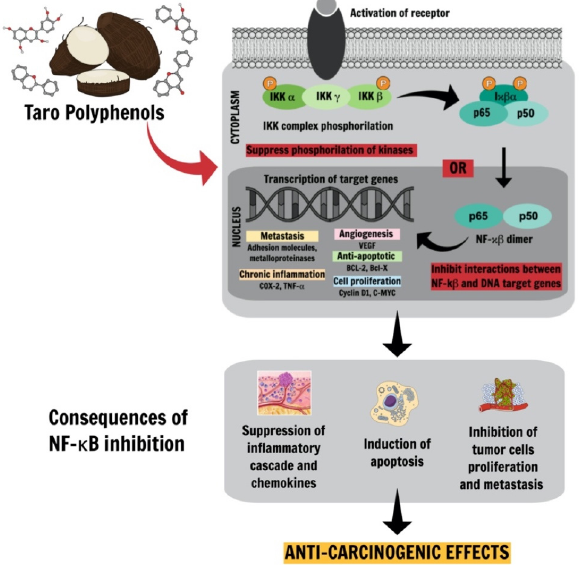
Figure 2. Therapeutic potential of taro phytochemicals: Anti-carcinogenic effects of taro bioactive compounds on the non-canonical NF- κ B pathway could be mediated by polyphenols. Polyphenols can mediate the suppression of NF- κ B transcriptional factor resulting in the inhibition of pro-inflammatory signaling cascade, apoptosis induction, cell proliferation control, and metastasis. inhibitory kappa B kinase (IKK); vascular endothelial growth factor (VEGF); B-cell lymphoma 2 (BCL-2); B-cell lymphoma X (BCL-X); c-myelocytomatosis